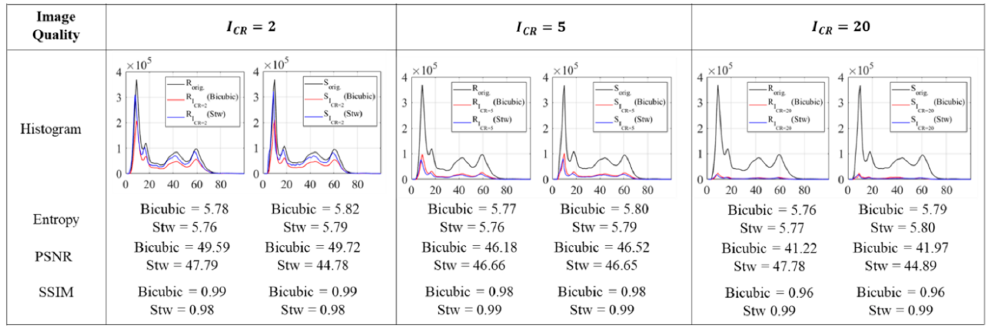
Figure 8. Compressed images histograms from reference, R , and search, S images using bicubic interpolation and spatial orientation tree wavelet (STW) resampling methods for I CR = 2, 5, and 20 and quantity index metric (the gray intensity value range is selected between 0 to 100 for better visualization).